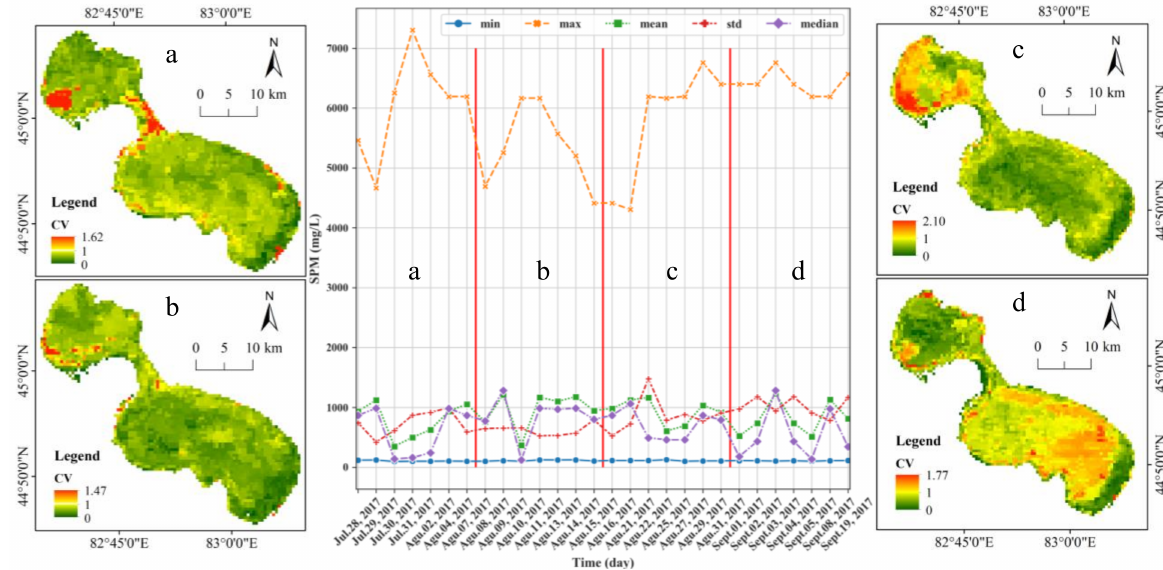
Figure 16. The SPM variation trend in Ebinur Lake in 28 days and the distribution of the coefficient of variation (CV) in different periods (CV < 1 means low variability; CV ≥ 1 high variability